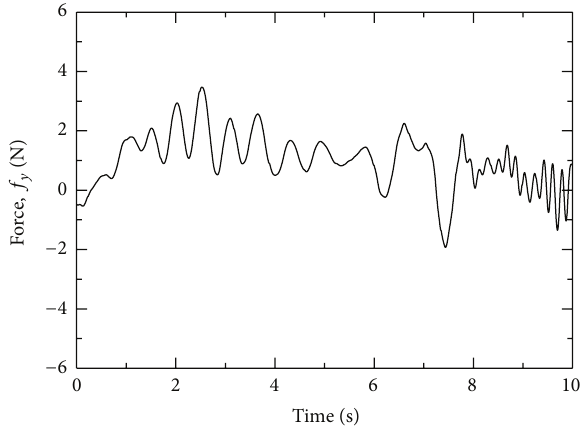
Figure 17: Actual applied force, 𝑓 𝑦